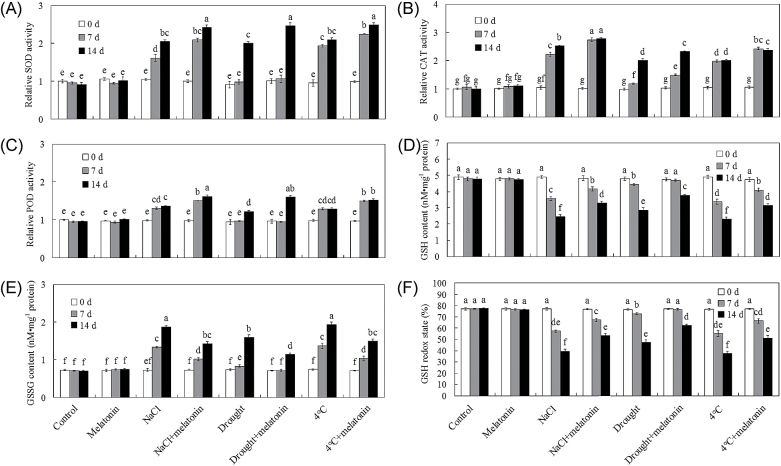
Effects of exogenous melatonin on ROS-related antioxidants in bermudagrass response to abiotic stress. (A–F) Quantifications of SOD activity (A), CAT activity (B), POD activity (C), GSH (D), GSSG (E), and GSH redox state (F) of 28-day-old plants with different treatments (control and 20 μM melatonin) under control, 300mM NaCl, drought, and cold (4 °C) stress conditions on the designated days. The results shown are the means ±SEs, and bars with different letters above the columns of figures indicate significant differences at P<0.05 (Duncan’s range test).